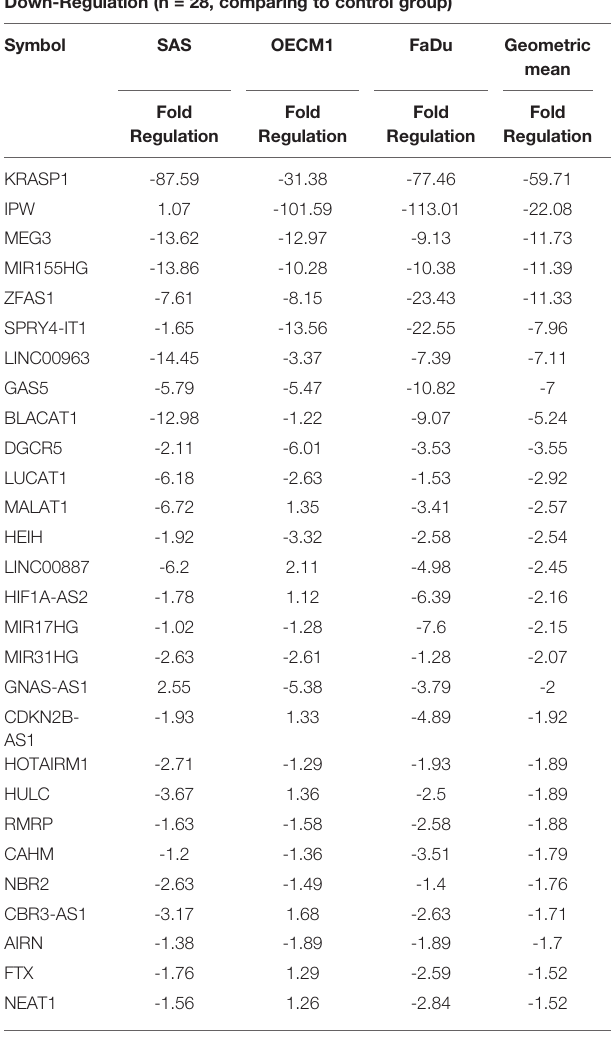
TABLE 1 | List of upregulated genes across the HNC cell line group compared with the normal keratinocyte cell line group. Up-Regulation (n = 27, comparing to control group) Symbol SAS OECM1